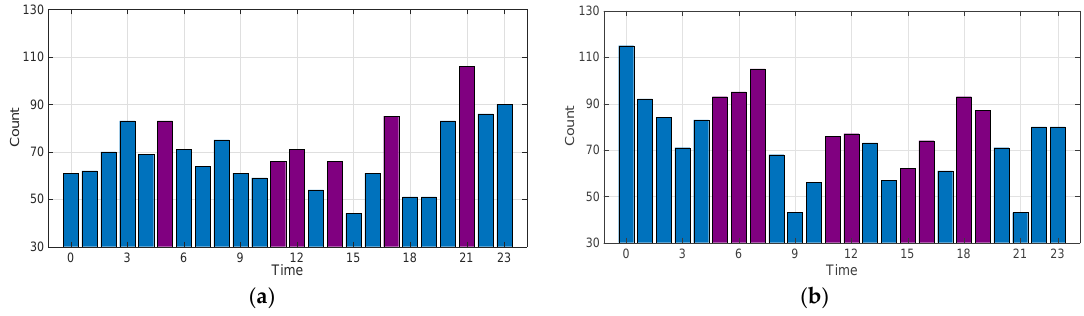
Figure 2. Total number of frequency fluctuations occurred in the corresponding time during the weekdays for two months in Java-Madura-Bali (JAMALI) power grid (frequency fluctuation higher than the nominal frequency deadband (+36 mHz) and longer than 1 min). ( a ) ∆f < 0.036 Hz ( b ) ∆f > 0.036 Hz.